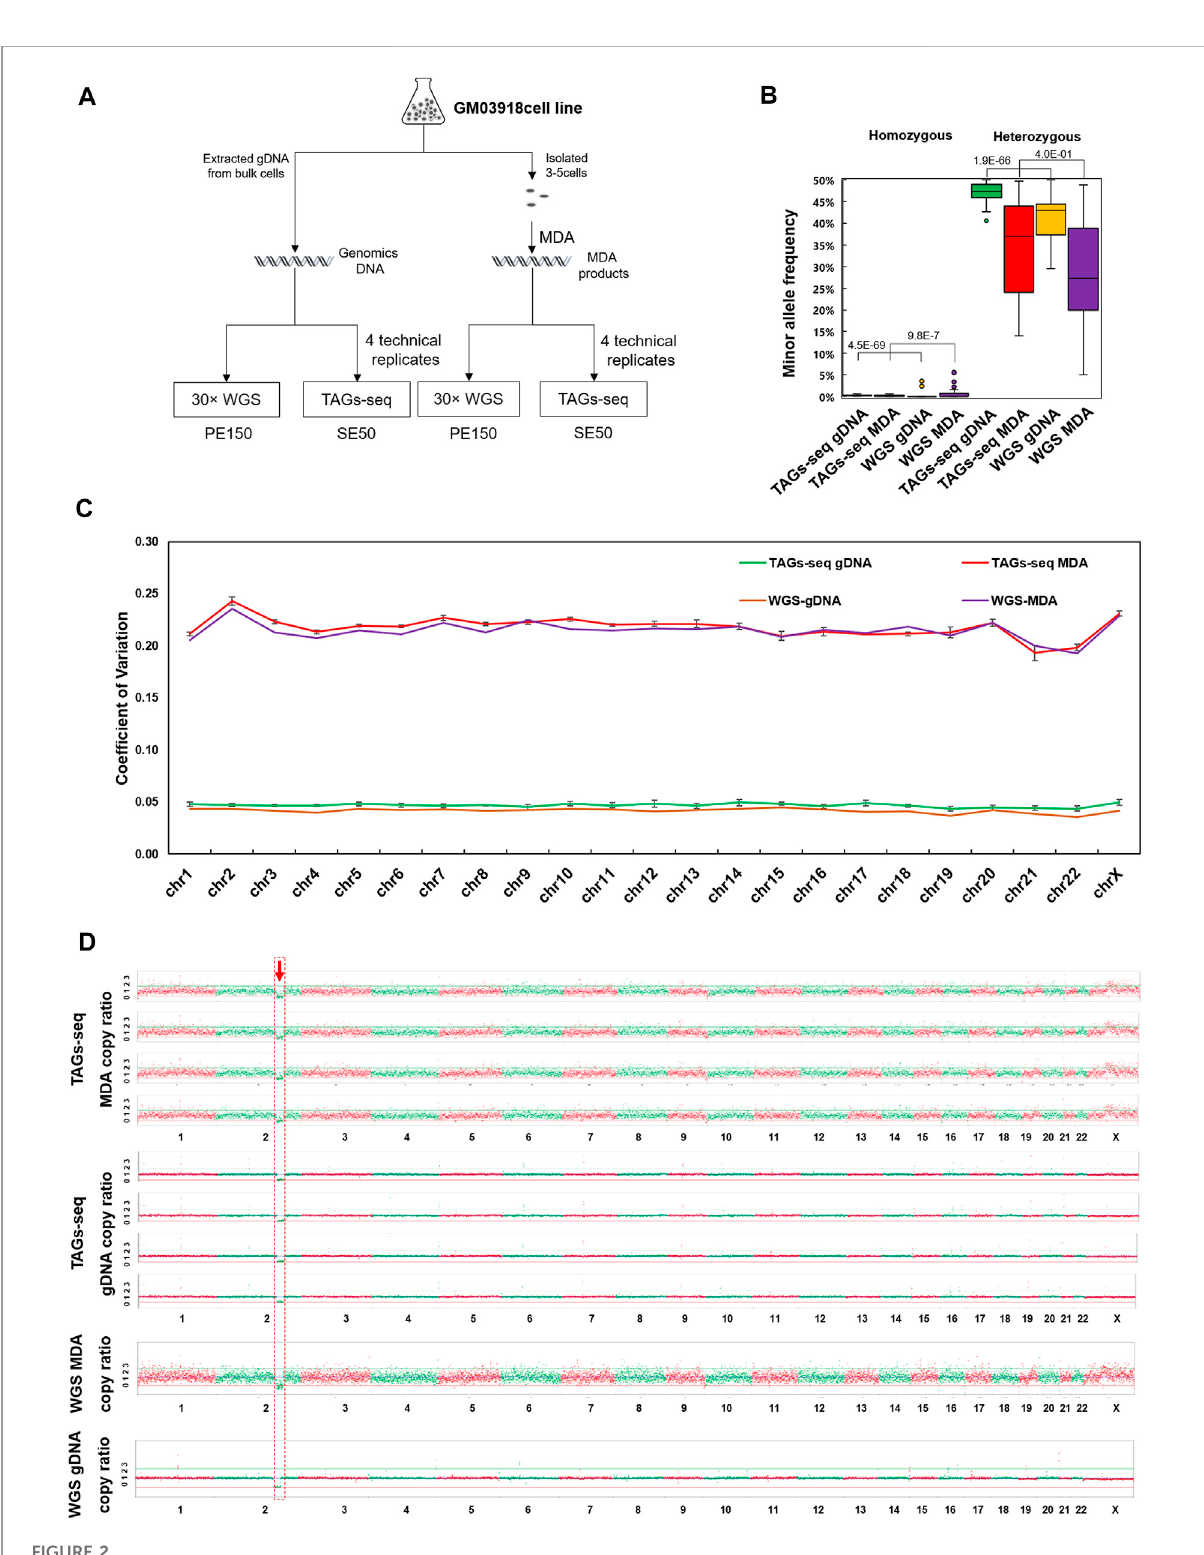
FIGURE 2 The performance of TAGs-seq in GM03918 cell line. (A) Experiment design of the TAGs-seq in GM03918 cell line. Bulk cells gDNA and multiple displacement ampli fi cation (MDA) product of the 3-5 isolated cells were prepared, which were then tested by ~30× whole genome sequencing (WGS) and 0.1 – 0.5 × TAGs-seq (4 technical replicates), respectively. (B) Distribution of MAR of homozygous and heterozygous sites in gDNA and MDA products by the TAGs-seq and WGS. We de fi ne homozygous site which MAR lower than 10% and heterozygous sites which MAR equal